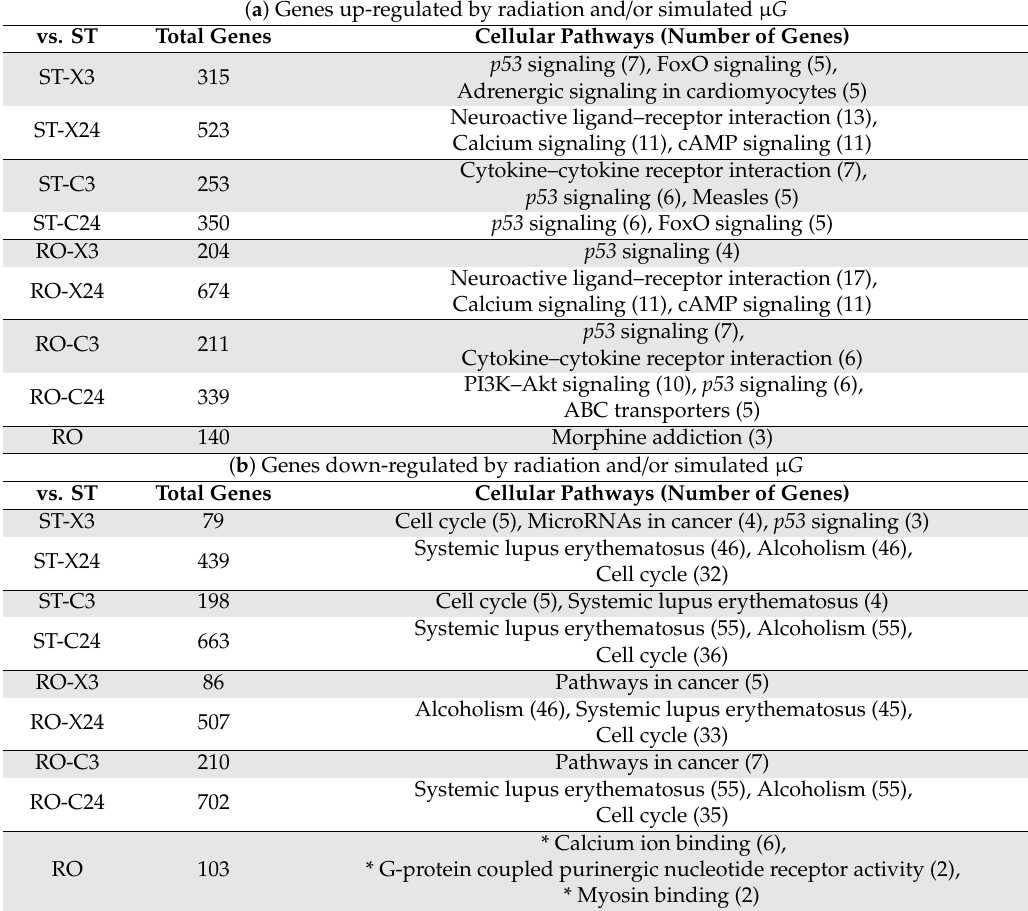
ST, standing 1 G ; RO, rotation for simulated µ G ; X, X-ray irradiation; C, carbon-ion irradiation; 3, 3 h after irradiation; 24, 24 h after irradiation. * The list by Gene Ontology-Molecular Function-Direct with DAVID ( p < 0.05, top three show a higher percentage in narrowing as biological